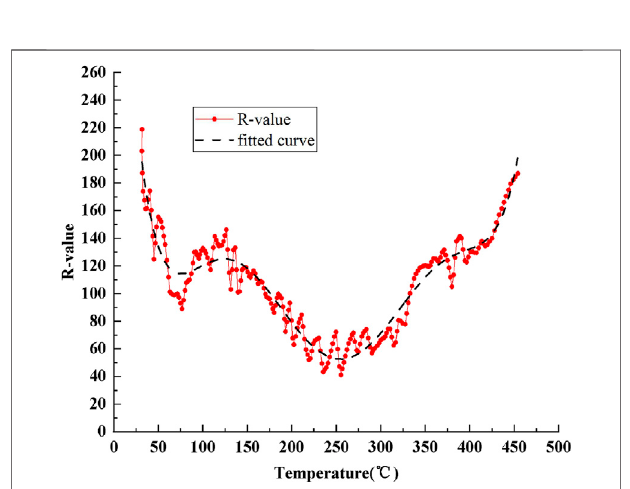
FIGURE 3 | R-value curve and its fi tting curve with temperature